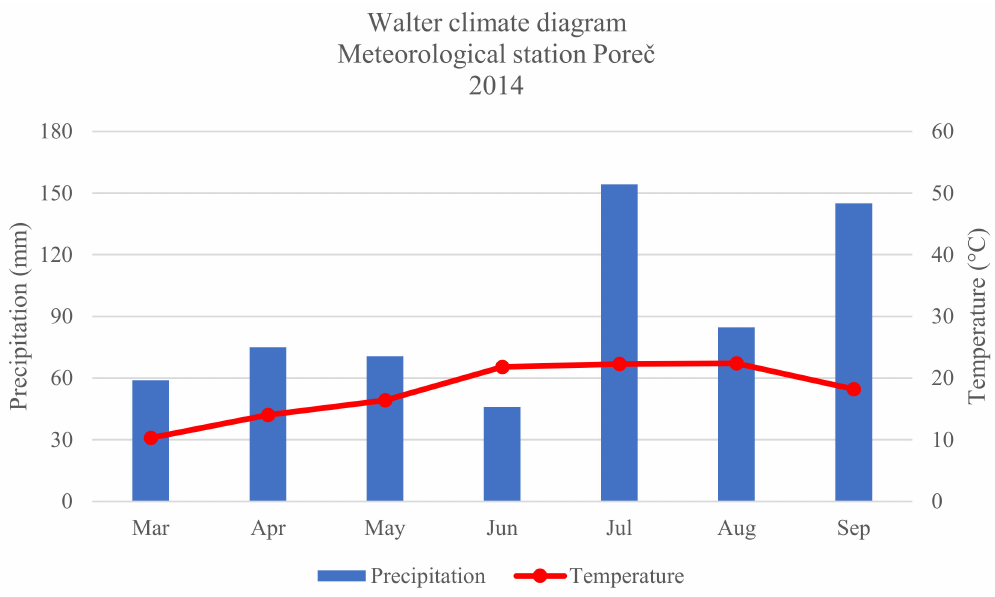
Figure 2. Walter climate diagram for meteorological station Poreˇc, year